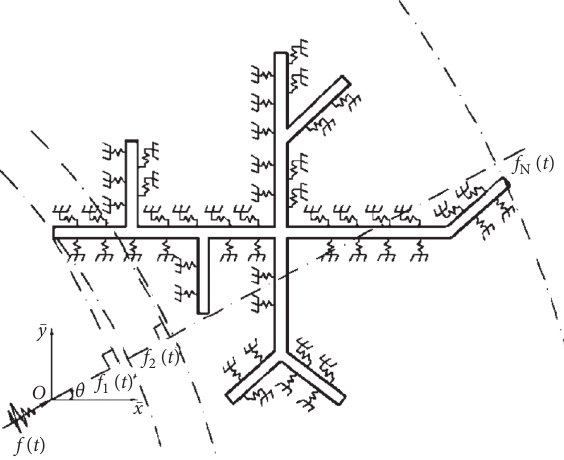
Figure 4: Ground motion input.